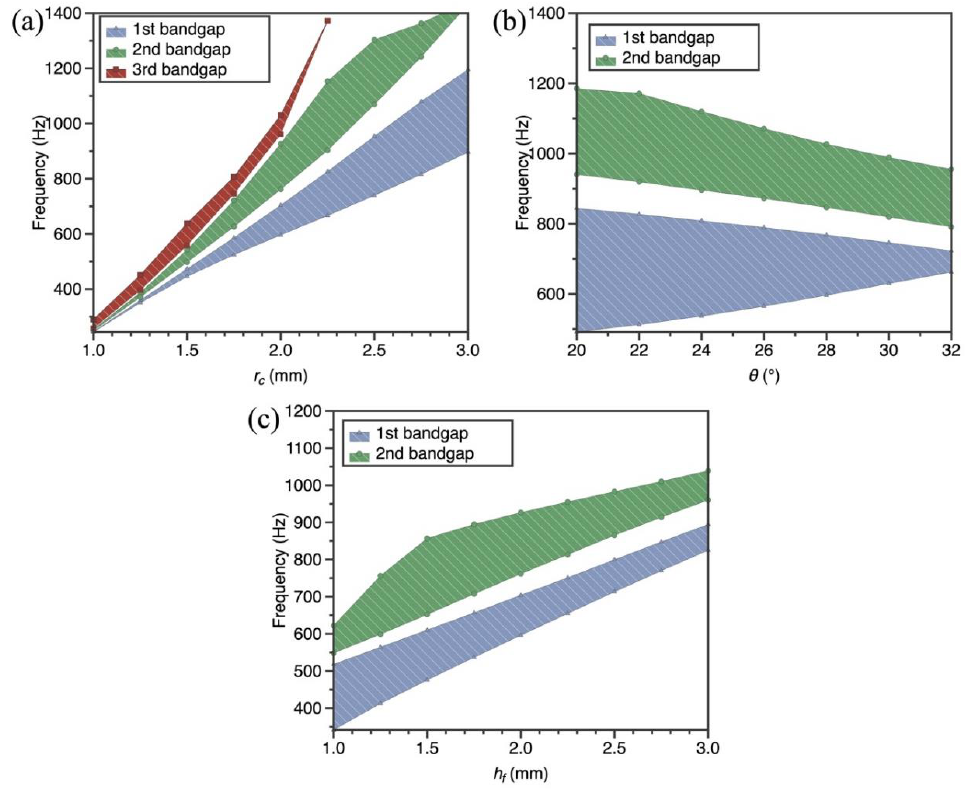
Figure 7. Effect of geometric parameters of lattice core and face-sheets on bandgaps of the SPLCRR. ( a ) lattice core rod radius values r c ( b ) angle values θ ( c ) face-sheet thickness values h f